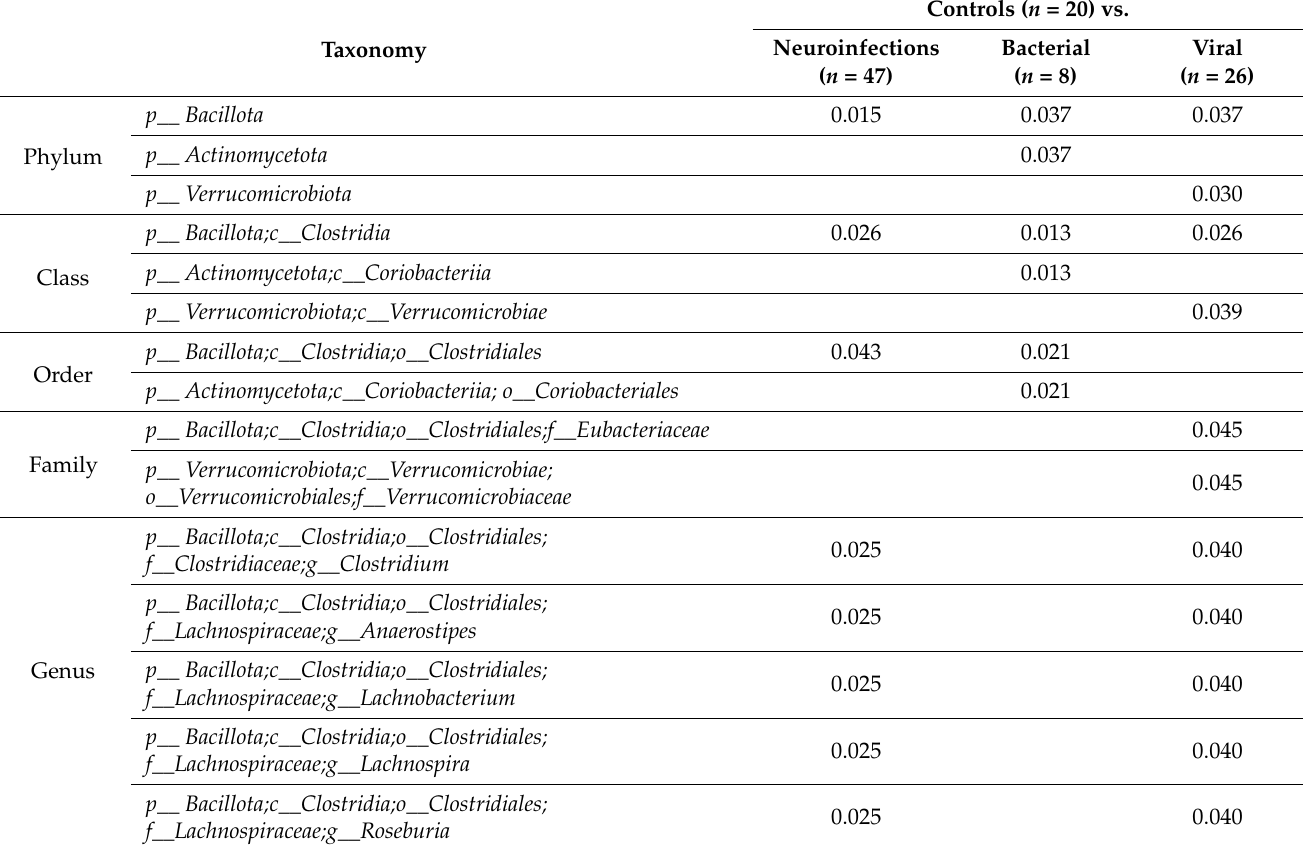
Table 2. Differences at taxonomic ranks between patients with neuroinfections and healthy